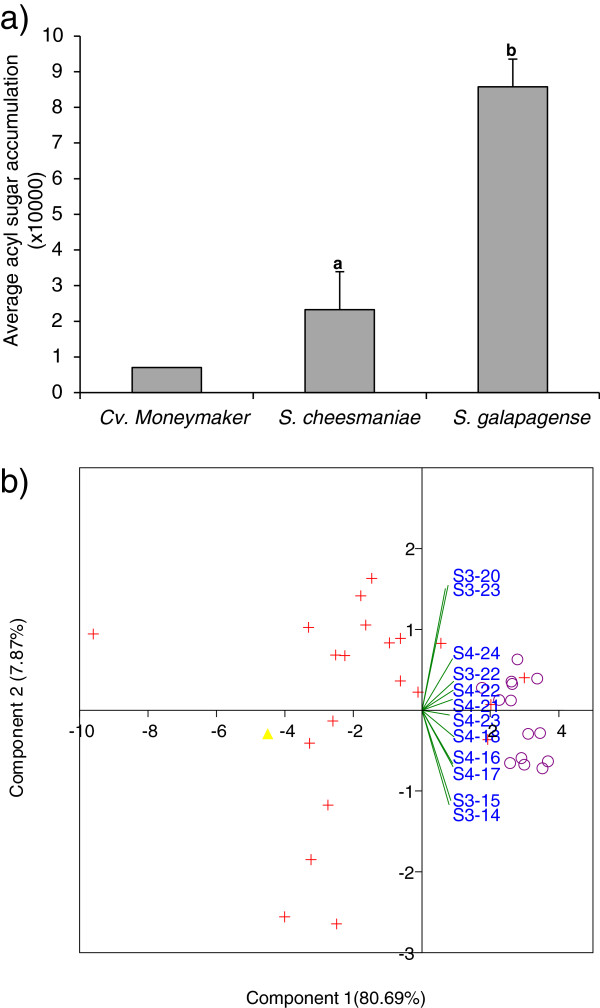
Acyl sugar accumulation per species and accession. a) Average acyl sugar accumulation per species; values for S. galapagense and S. cheesmaniae represent means and SD of 14 and 21 plants, respectively. Cultivar Moneymaker is included as reference. Different letters indicate statistical differences according to LSD test (p < 0.05); b) PCA-biplot score of the tomato accessions based on acyl sugar accumulation. Solanum galapagense (violet circle symbol, S. cheesmaniae (red plus sign symbol) and S. lycopersicum cv. Moneymaker (yellow rhombus symbol). Lines indicate the loadings of the different acyl sucroses.